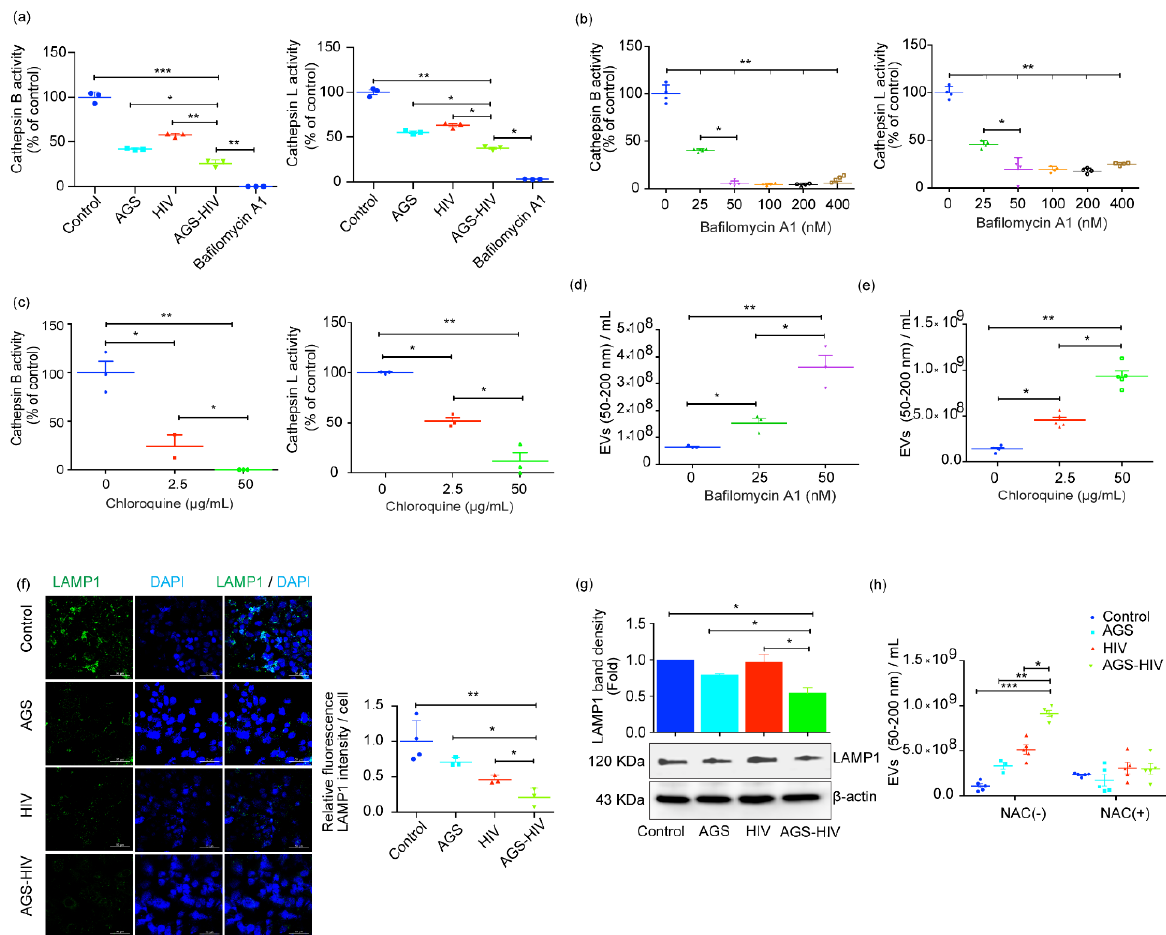
Figure 4. AGS–HIV treatment inhibits lysosomal activities and downregulates LAMP1 in RLW XP-GFP cells. ( a ) Cathepsin B and cathepsin L activities were significantly suppressed by AGS treatment in HIV-infected RLW XP-GFP cells. Bafilomycin A1 was selected to inhibit cathepsin activities and served as a positive control for lysosome inhibition. ( b ) Bafilomycin A1 was used, at different concentrations, to derive gradient in the activities of cathepsins B and L. ( c ) Chloroquine was used at low (2.5 µ g/mL) and high concentration (50 µ g/mL), to derive gradient in the activities of cathepsin B and cathepsin L. ( d , e ) EVs count in the size range of sEVs (50–200 nm) with different concentrations of bafilomycin A1 ( d ) and chloroquine ( e ), as assessed with NTA. ( f ) RLW XP-GFP cells grown on the coverslip and treated with AGS and HIV were probed with LAMP1 antibody, and images were acquired on confocal microscopy. DAPI was used to counterstain the nucleus. For the quantification, Lamp1 intensity was measured from at least three independent images per group and divided by the total number of DAPI positive nuclei. Images were acquired on a 40x objective and scale bar = 50 µ m. ( g ) Total protein from whole-cell lysates was extracted from untreated and treated groups and analyzed for lysosome-associated membrane protein (LAMP1) by Western blot. β -actin was used as a loading control. Representative Western blot and densitometric analysis of the LAMP1 level are shown. ( h ) EVs count in the size range of sEVs (50–200 nm) from the cells pretreated with or without the addition of N-Acetyl-L-cysteine (NAC). ( a – h ) Data were obtained from at least three independent experiments and presented as Mean ± SEM. Statistical significance between treatment groups is indicated by asterisk(s) and determined by one-way ANOVA (*** p ≤ 0.001, ** p ≤ 0.01, and * p ≤